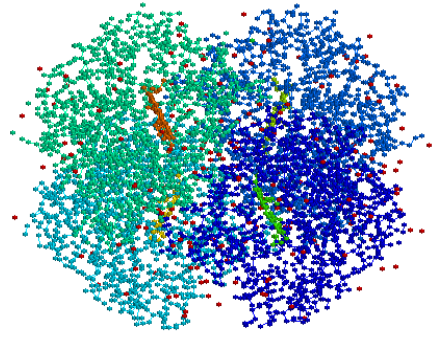
Fig. 3. Quaternary structure of the human hemoglobin (PDB ID: 4HHB, all four chains) in the atomic representation, colored by chain.